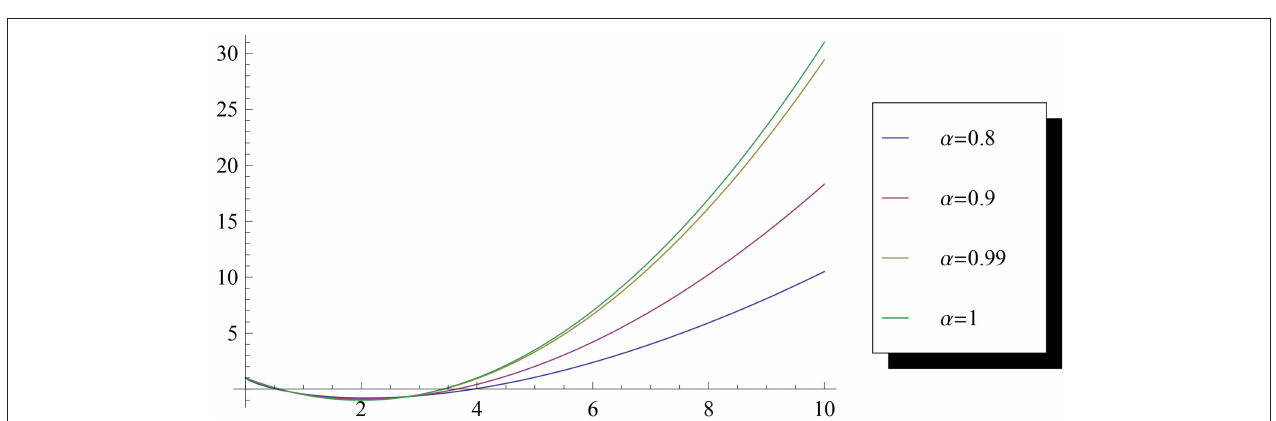
FIGURE 3 | A plot of L 0 2, α , for α = 0.8,0.9,0.99,1.